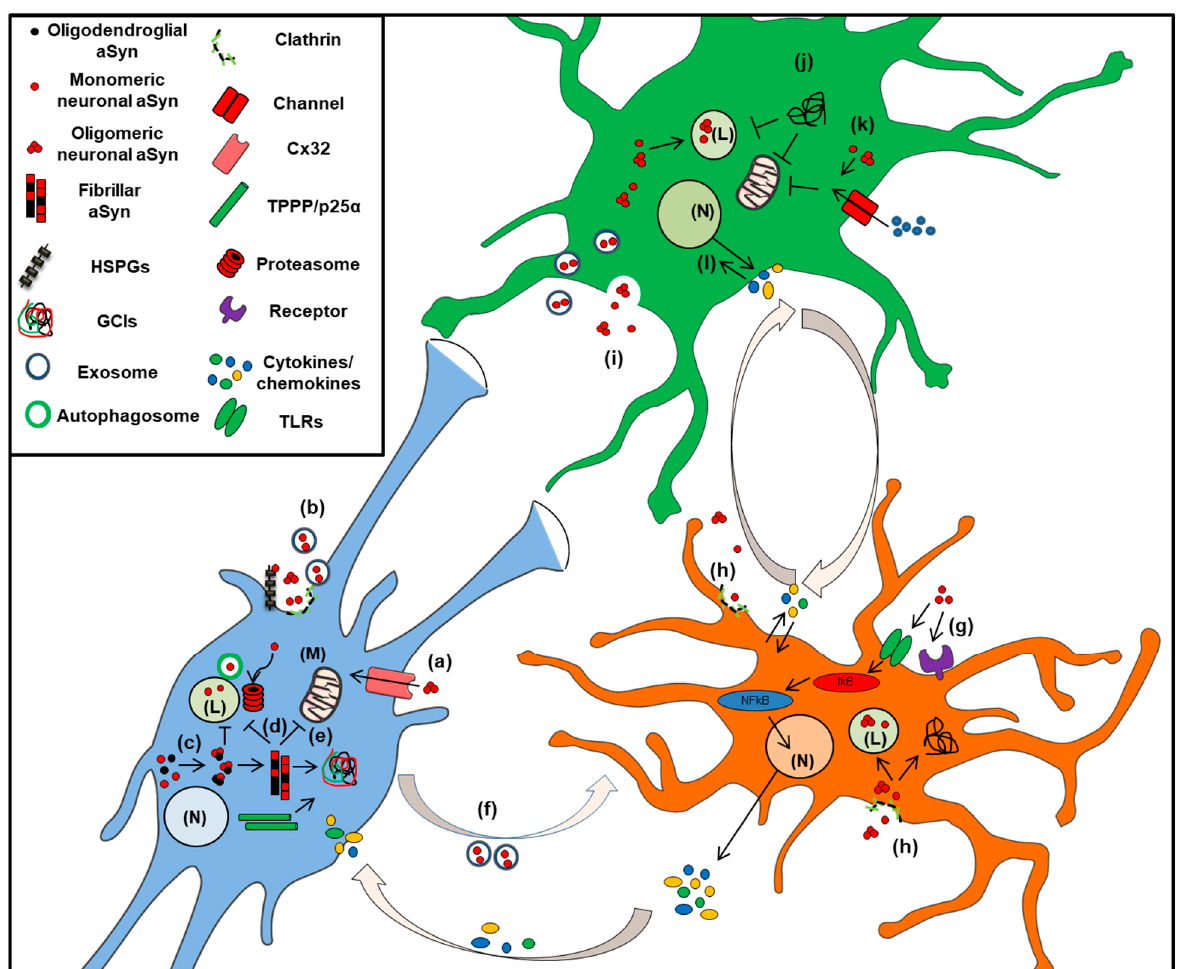
Figure 3. A complicated neuron-glial interrelationship. (a) Oligomeric aSyn enters oligodendrocytes (blue) via binding to the gap junction protein connexin-32 (Cx32), (b) Neuronally-derived aSyn enters oligodendrocytes via clathrin-mediated endocytosis, exosomal transportation, or via binding to Heparan Sulfate ProteoGlycans (HSPGs), (c) Inside oligodendro- cytes, neuronal aSyn (red) initiates the seeding of the endogenous oligodendroglial aSyn (black) and together with the oligodendroglial-specific TPPP/p25 α protein, they lead to the formation of GCIs, (d) aSyn aggregates impair the proteolytic machineries of oligodendrocytes [(proteasome and lysosome (L)], (e) Misfolded aSyn leads to mitochondrial (M) dysfunction and subsequent cell toxicity in MSA, (f) Oligodendroglial-derived exosomes containing aSyn have been shown to transfer to microglial cells (orange), (g) Extracellular aSyn stimulates TLRs and other receptors (i.e., Fc γ R, P2X7 etc) to activate microglial transcription factors, such as NFkB, for the production of various pro-inflammatory cytokines (IL1 β , TNFa) and chemokines that induce astrocyte (green) reactivity and oligodendroglial damage, (h) Neuronally-se- creted aSyn is taken up by microglial cells via clathrin-mediated endocytosis and is then driven to the lysosome (L) for degradation. In pathological conditions, though, it accumulates into aSyn insoluble aggregates, (i) Free or exosome-asso- ciated aSyn released by neurons is transmitted to astrocytes via endocytosis and enters the lysosome (L) for its clearance, (j) In disease, aSyn aggregates are formed that lead to lysosomal (L) impairment and mitochondria (M) dysfunction, (k) In astrocytes, aSyn triggers the opening of channels (i.e., Cx43 and Panx1), leading to dysregulation in Ca 2+ homeostasis and altered mitochondrial morphology, (l) Microglia-secreted cytokines and chemokines activate astrocytes to further produce